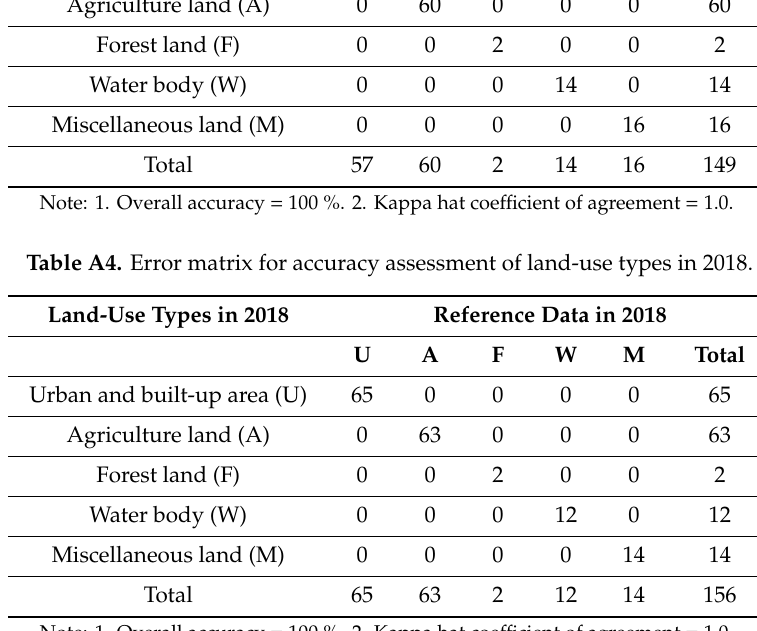
Table A5. Transition area matrix for land-use change between 2014 and 2016. Land-Use in 2016 Land-Use Types (sq. km)